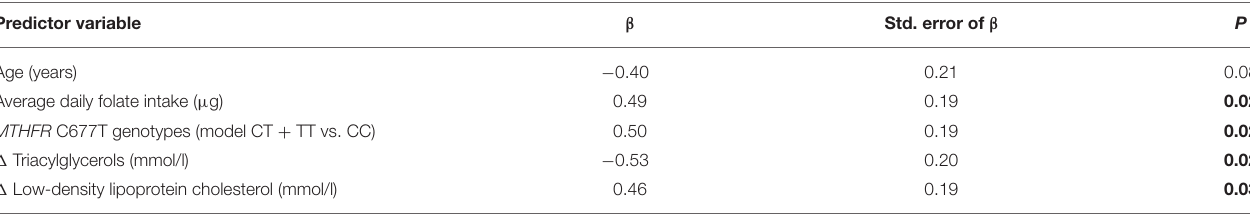
TABLE 2 | Multiple regression analysis for the change ( 1 ) in LINE-1 methylation levels (%) in women who consumed polyphenol-rich Aronia melanocarpa juice (AMJ treatment, N = 22). Predictor variable